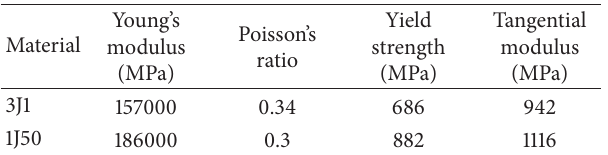
Table 1: Mechanical properties of 3J1 and 1J50.